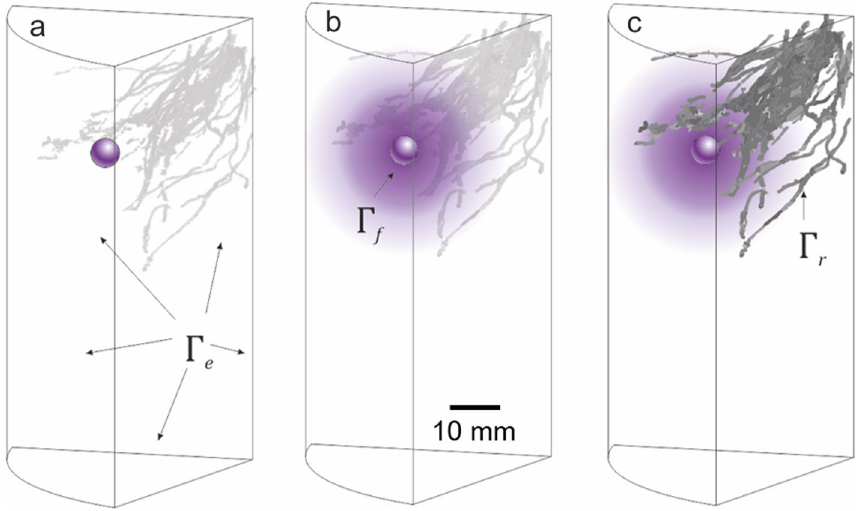
Figure 1. Visual description of 3D image-based modelling domain and model progression. The surface boundaries representing the edge of the pot and internal artificial boundaries where we subsample the image, Ŵ e are shown on ( a ); the fertiliser surface, Ŵ f on ( b ); and the root surfaces, Ŵ r on ( c ). ( a ) The initial state of the model with the roots deactivated and the fertiliser pellet primed to start dissolution; ( b ) In the first 6 weeks the roots remain inactive but the fertiliser pellet releases phosphorus into the soil which diffuses over this period; ( c ) After 6 weeks the roots reached the pellet (as calculated from the time-resolved XCT-data) and the roots are activated and take-up phosphorus from the soil. The phosphorus continues to diffuse in the soil. Purple shading is for illustrative purposes